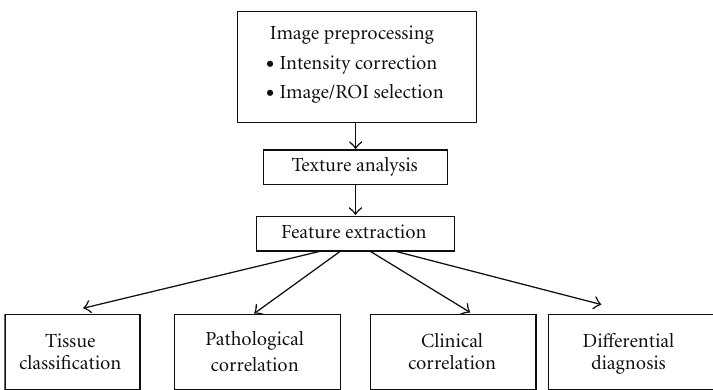
Figure 1: Overview of general texture analysis pipelines in the MRI of